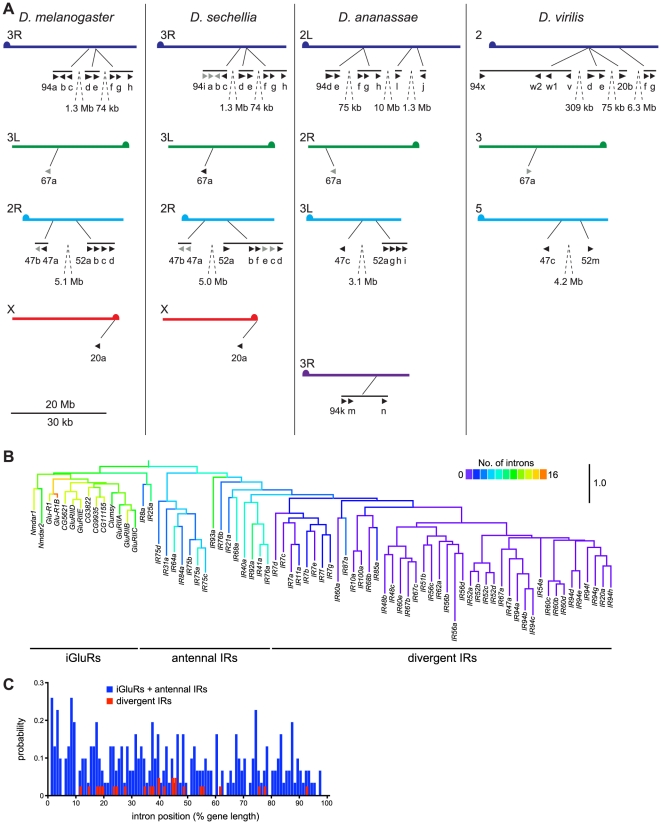
Mechanisms of IR repertoire expansion.(A) Genomic location of the IR genes (black arrowheads; pseudogenes in grey) belonging to the IR94 and IR52 clades in D. melanogaster, D. sechellia, D. ananassae and D. virilis. Equivalent chromosome arms (Muller elements) (labelled on the left of each chromosome arm) between the species are indicated by colour and horizontal alignment [93]. Tandem arrays of genes are indicated by horizontal black lines, and the distances between close arrays are shown. The “IR” and some number prefixes for gene names are omitted in clusters where space is limiting. The scale bar represents 20 Mb for the chromosomes and 30 kb for gene lengths and distances between genes within the same tandem array. (B) Phylogenetic tree of D. melanogaster iGluRs and IRs, in which branches are colour-coded by the number of introns in each extant gene sequence or predicted ancestor. The tree was built with RAxML under the WAG model of substitution, with 1000 bootstrap replicates, and the colours representing intron numbers were inferred and displayed with Mesquite. Pseudogenes were excluded from this analysis. The scale bar represents the expected number of substitutions per site. (C) Histogram illustrating the distribution of intron positions as a percentage of protein length for iGluRs and antennal IRs (blue) and divergent IRs (red). Each bar represents the probability of occurrence of an intron at a given percentile of the protein.